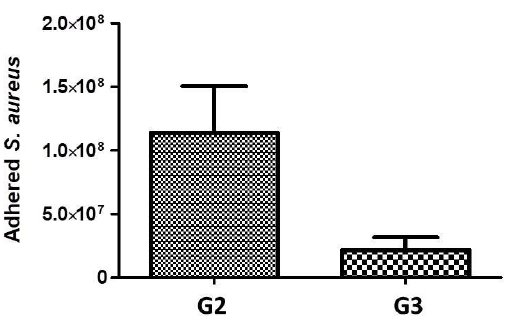
Figure 14. Number of adhered S. aureus bacteria on the grooved PLA samples surface (G2—PLA F = 1.7 J/cm 2 , V = 0.6 mm/s; G3—control PLA samples).